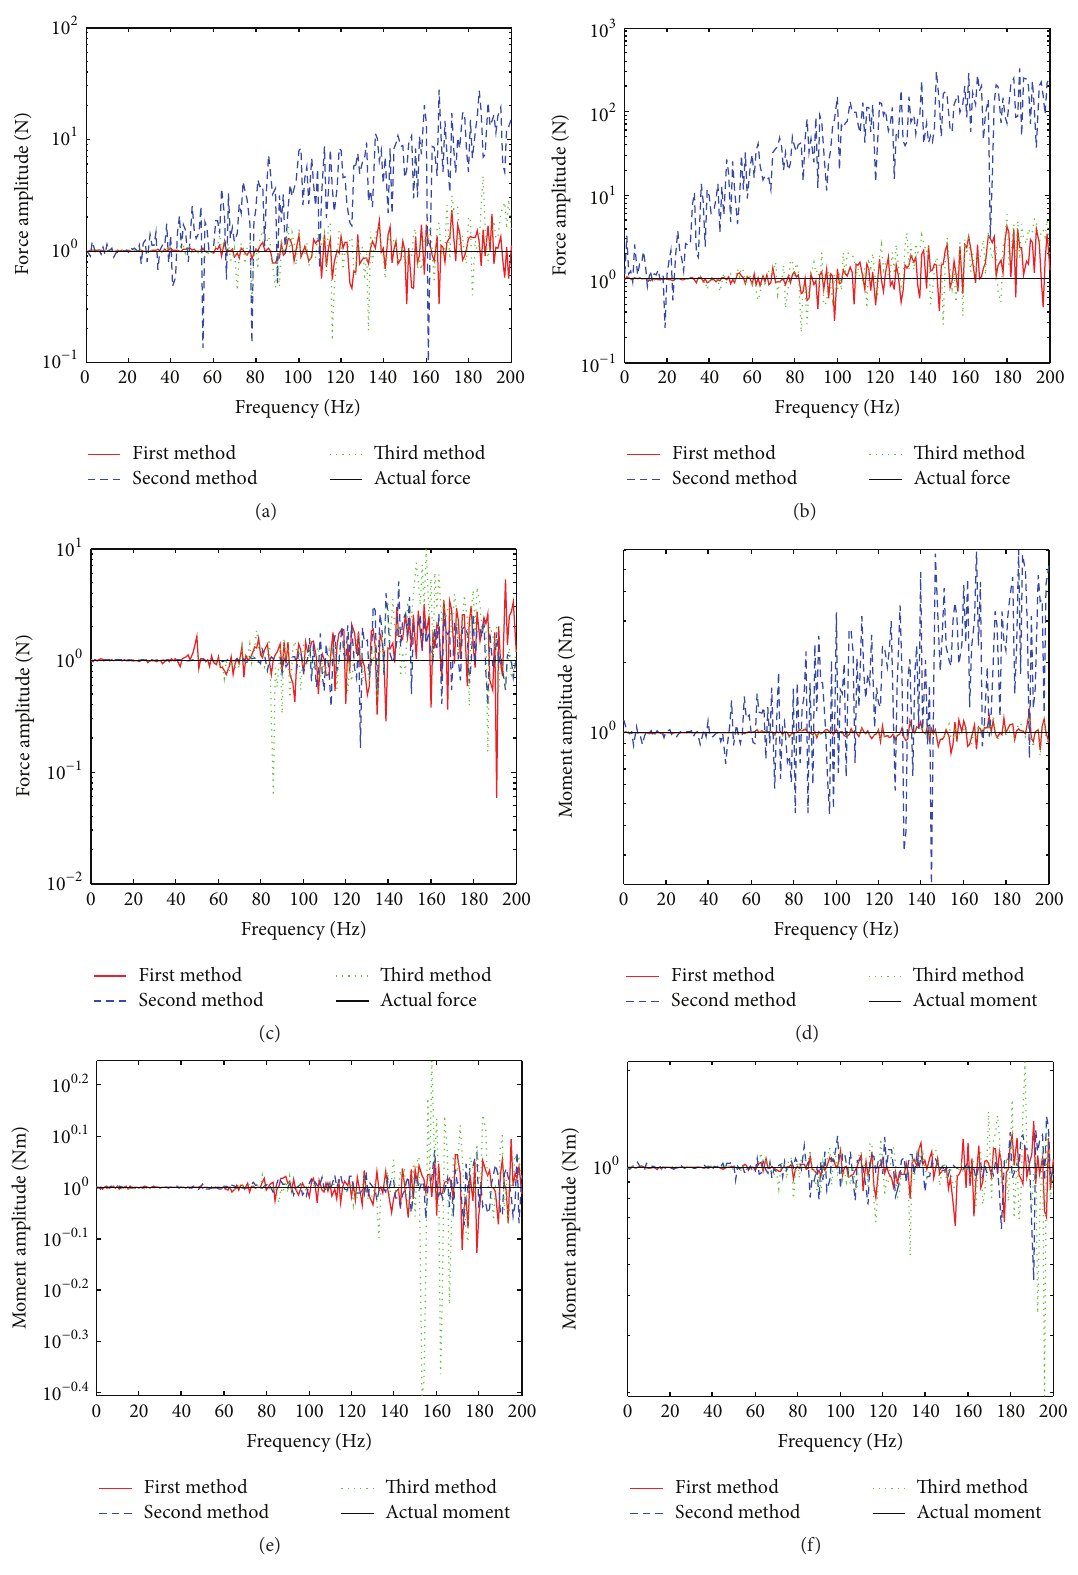
Figure 5: Comparison of estimated inputs by three different methods and actual inputs. (a) Force in 𝑥 -direction. (b) Force in 𝑦 -direction. (c) Force in 𝑧 -direction. (d) Moment around 𝑥 -direction. (e) Moment around 𝑦 -direction. (f) Moment around 𝑧